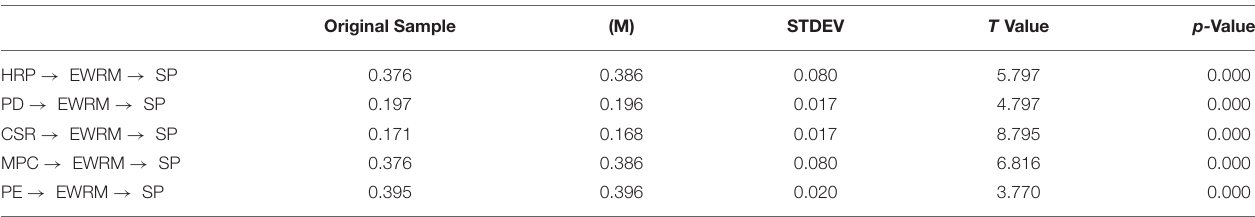
TABLE 5 | Mediating hypothesis